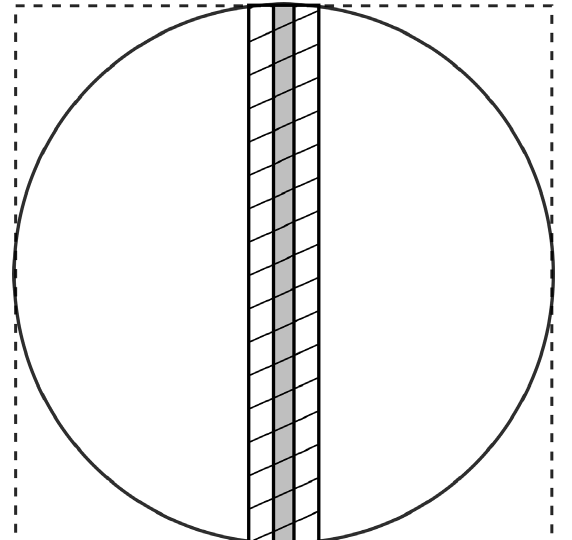
Figure 4 T op view of the cylindrical specimen. The hatched area representing where a plane stress simplification would incur in less distortions. The grey area corresponds in scale to the thickness adopted by the